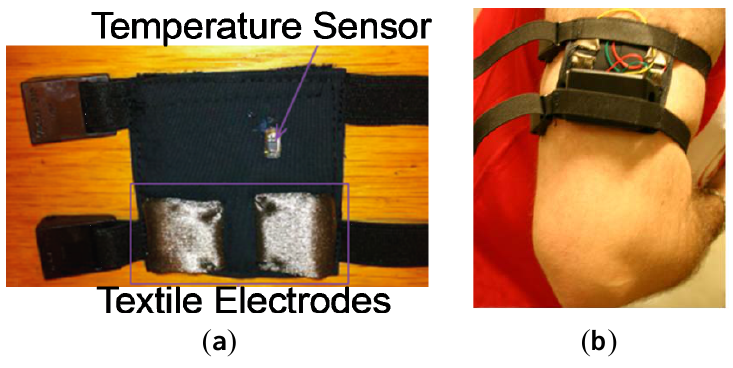
Figure 9. ( a ) Constructed upper arm strap. ( b ) Measuring device and strap worn on the upper